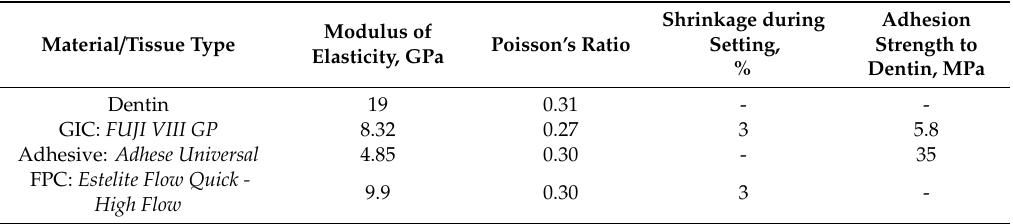
Table 1. Data for materials used in the simulations